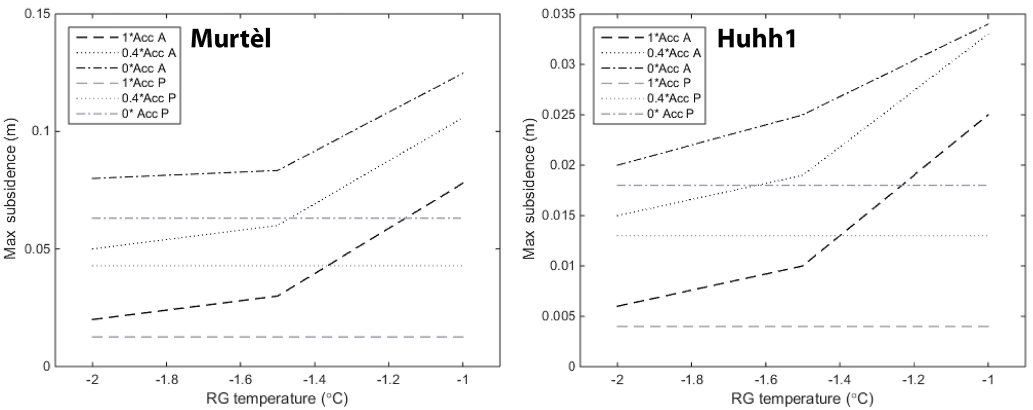
Figure 11. Modeled maximum annual subsidence rates in the deposition area of the rock glaciers in relation to the reference temperature and change in material input and for the two temperature models of Arenson and Springman (2005; black lines) and Paterson and Budd (1982; grey lines) immediately after a 1 ◦ C temperature step increase. Note the different scales for subsidence for the two rock